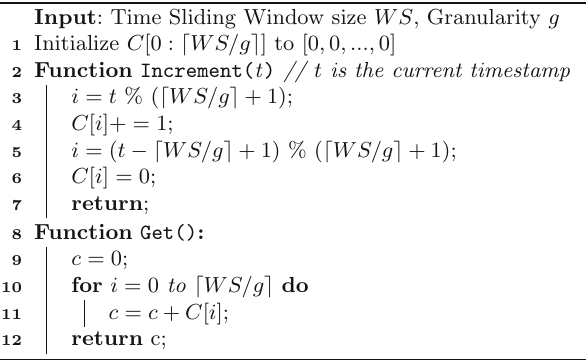
Algorithm 2: Time Sliding Window